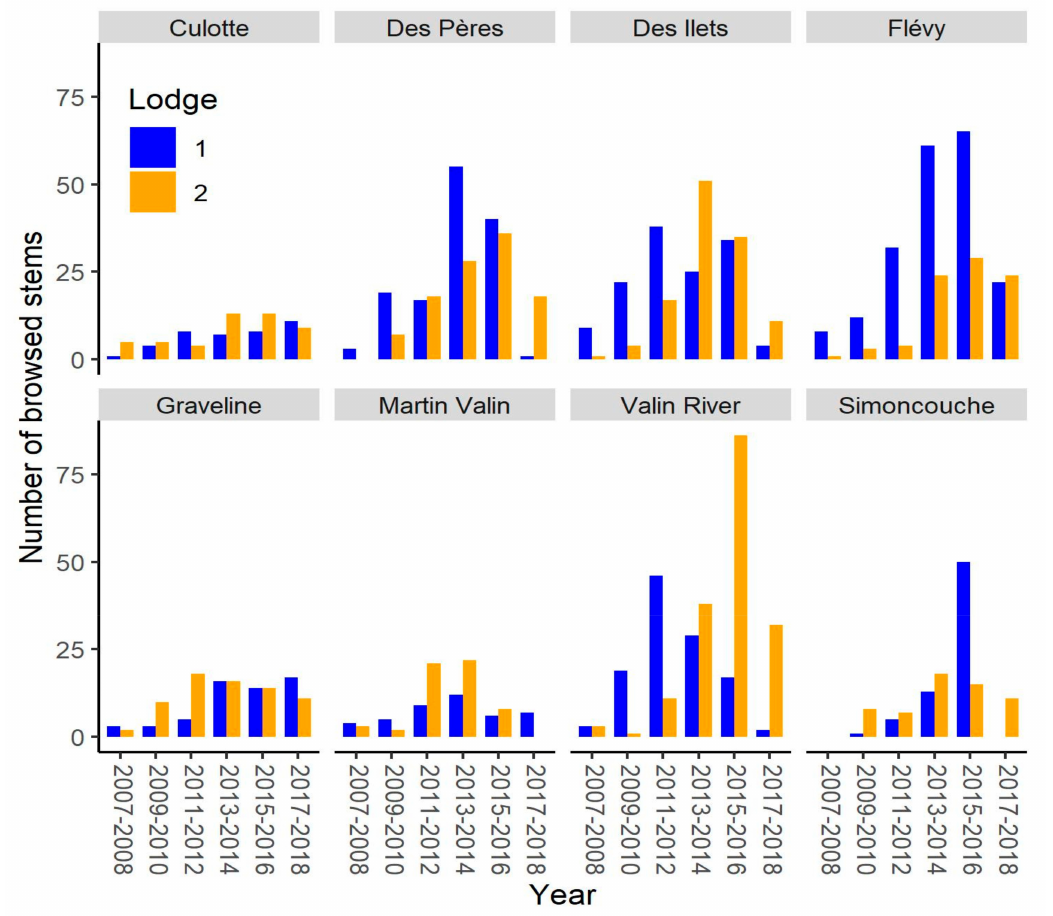
Figure 3. Number of stems browsed by beaver during 2007–2018 for each of the pair of lodges sampled on each of the eight studied water